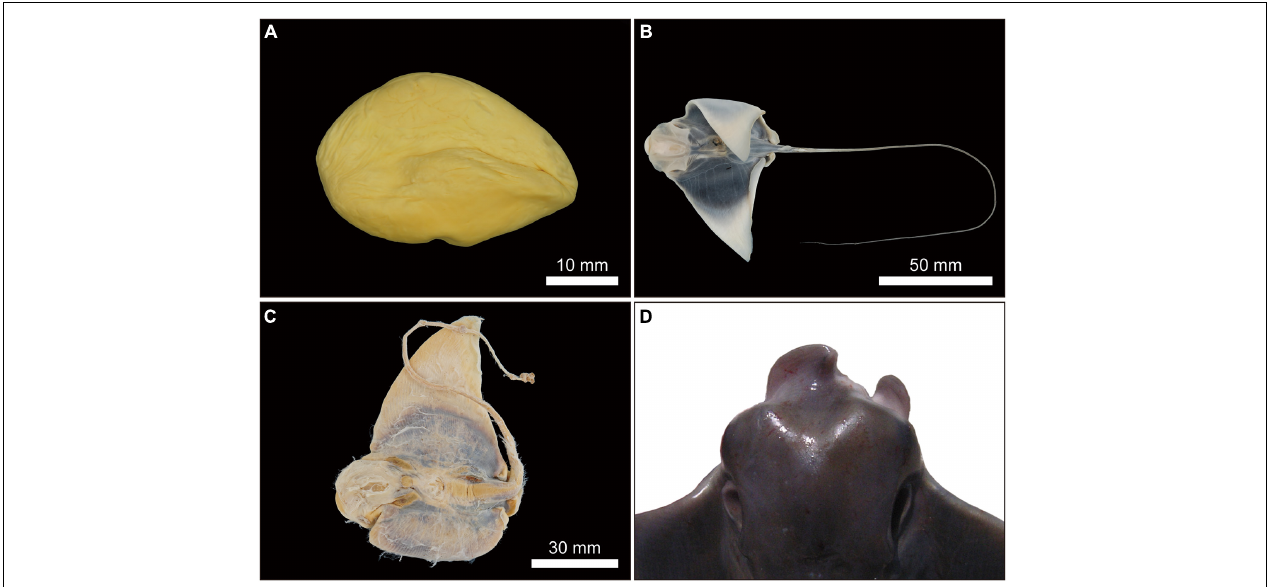
FIGURE 13 | Undeveloped or unfertilized uterine eggs or dead embryos and abnormal morphological embryos of Aetobatus narutobiei . (A) Egg without embryonic development from a female collected in June 2010; (B,C) dead embryos from females collected in July 2019 (B) and September 2003 (C) and (D) an abnormal embryo in September